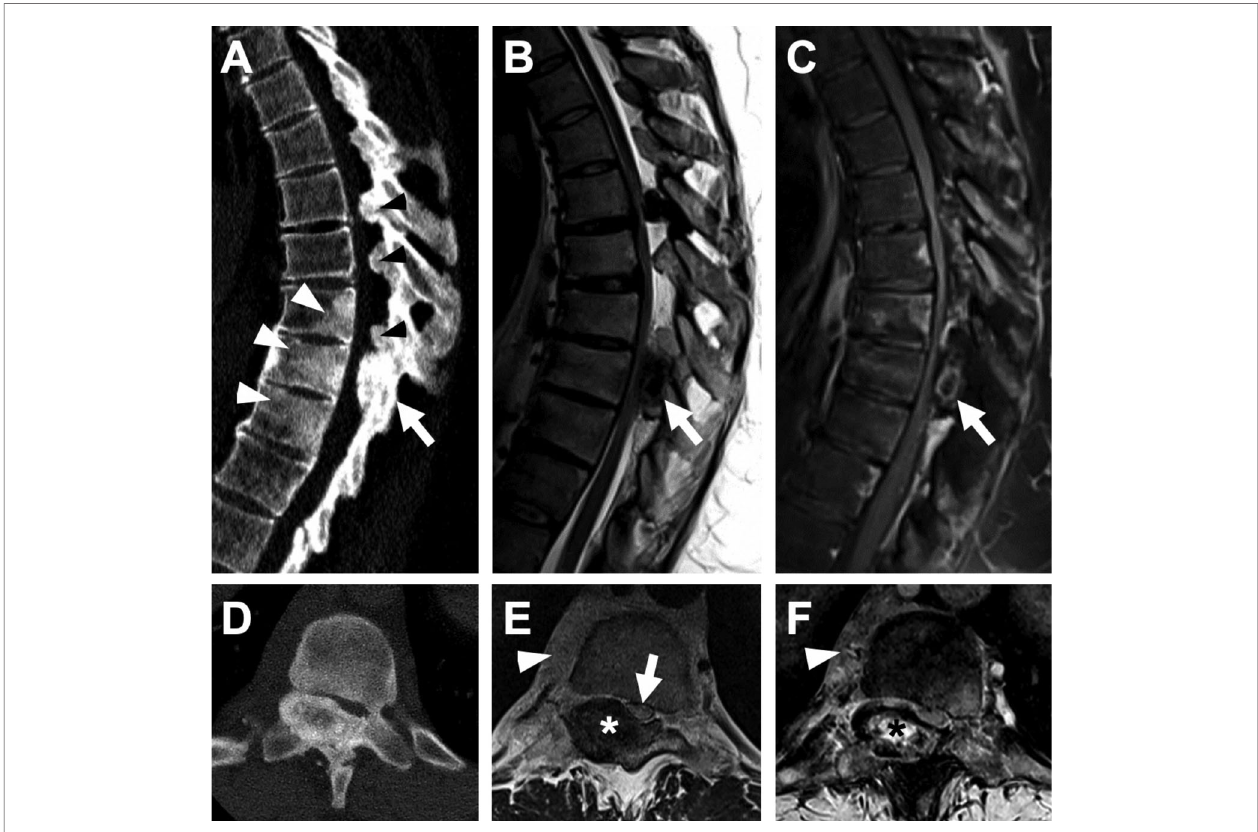
FIGURE 1 | Osteoblastoma with multilevel ligamentum fl avum ossi fi cation. ( A ) Sagittal CT and ( B ) T2-weighted and ( C ) fat-saturation post-contrast T1-weighted MR images show an expansile osseous lesion (arrow) centered at the right T9 lamina and pedicle with a central ring of enhancement. Note associated regional sclerosis in the T8-10 vertebral bodies (white arrowheads in A ) and prominent multilevel ligamentum fl avum ossi fi cation (black arrowheads in A ). ( D – F ) Corresponding axial images show central lucency within the osseous lesion with heterogenous low T2 signal and enhancement (asterisk), as well as marked canal stenosis and cord compression (arrow in E ). Note also enhancing right paravertebral soft tissue (arrowhead in E and F ). Ligamentum fl avum ossi fi cation and epidural lipomatosis also cause signi fi cant stenosis at T6-7, T7-8 and